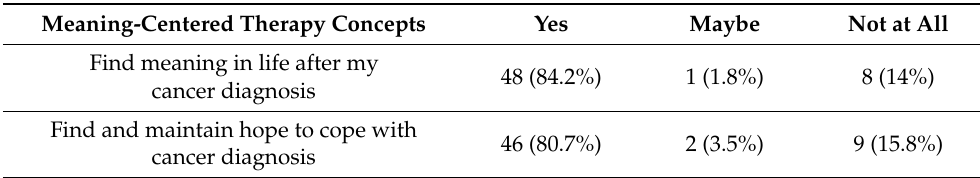
Table 5. Meaning-centered psychotherapy concepts: Patients.